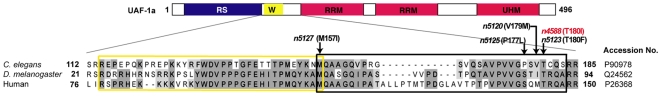

uaf-1 mutations define a UAF-1 region that affects the recognition of different 3′ splice sites.Comparison of the sequences of the U2AF large subunit between the RS domain and the first RRM domain from C. elegans, D. melanogaster and human. The mutations caused by the uaf-1(n4588), uaf-1(n5120), uaf-1(n5123), uaf-1(n5125) and uaf-1(n5127) mutations are indicated with arrows. RS: Arginine-Serine rich domain. W: U2AF small subunit-interacting domain. RRM: RNA recognition motif. UHM: U2AF homology motif. Black box: region of UAF-1a that might regulate the recognition of 3′ splice sites.